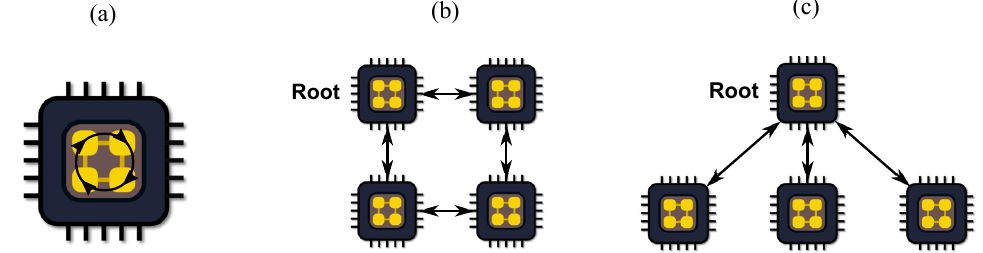
Figure 6. Information exchange between processors in different parallel schemes, ( a ) Centralized, ( b ) Decentralized, ( c ) Distributed. The arrow points in the direction of